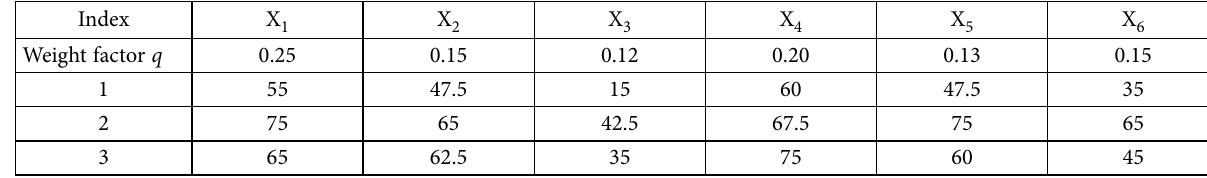
Table 5. Arithmetic mean value of decision-making index for project manager selection